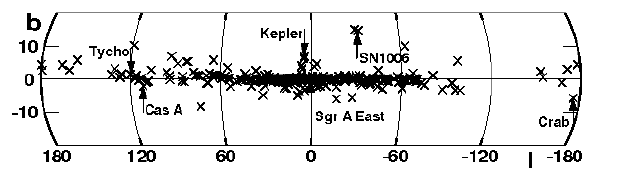
Figure 1: Locations of the supernova remnants in D.A. Green